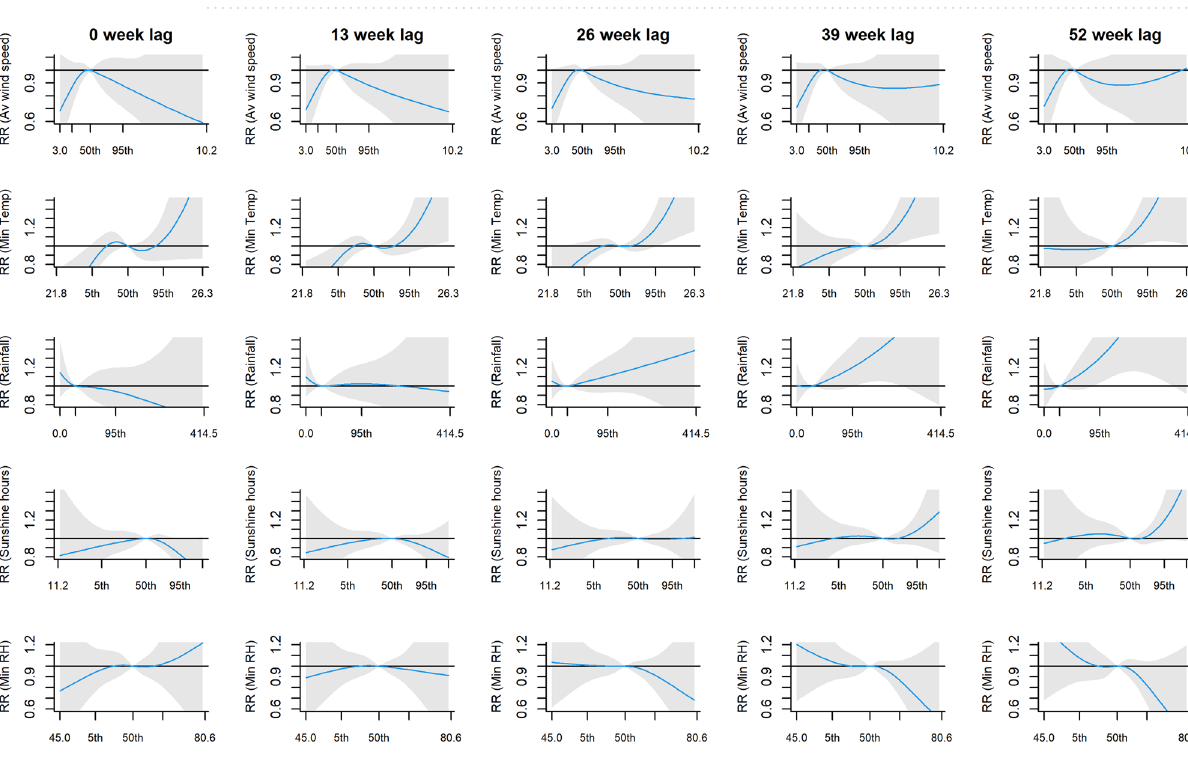
Figure 5. The lagged effects on the relative risk (RR) of smear-positive PTB incidence from final multivariate model, of (from top to bottom) average wind speed, minimum temperature, total rainfall, total sunshine hours and minimum relative humidity, at lags 0, 13, 26, 39 and 52 weeks. There are 5 x-axis label ticks for each plot, corresponding to the minimum, 5th percentile, 50th percentile, 95th percentile and maximum. The areas shaded in grey correspond to the 95% Confidence